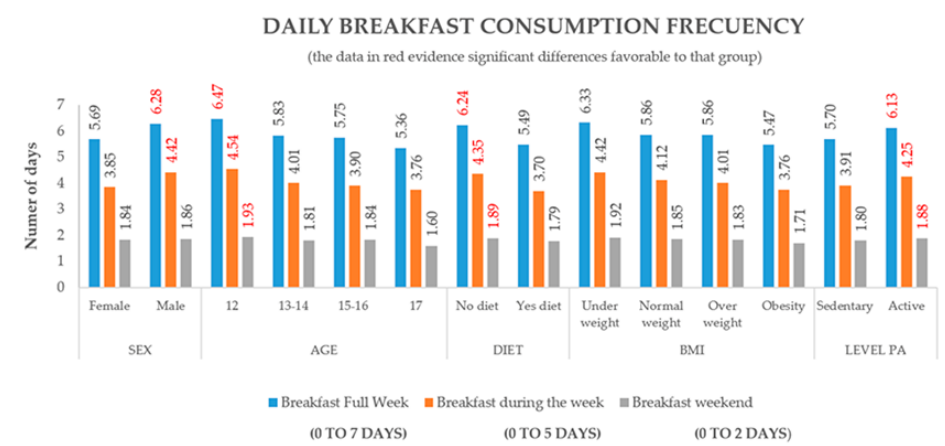
Figure 2. Frequency of breakfast consumption during the entire week, on weekdays and on weekends by sex, age, weight loss diet adherence, body mass index (BMI) and level of physical activity (PA). A dot represents the group with the highest and most significant difference.